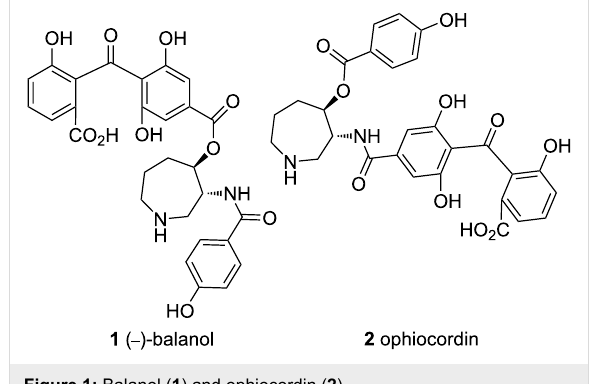
Figure 1: Balanol ( 1 ) and ophiocordin ( 2 ).